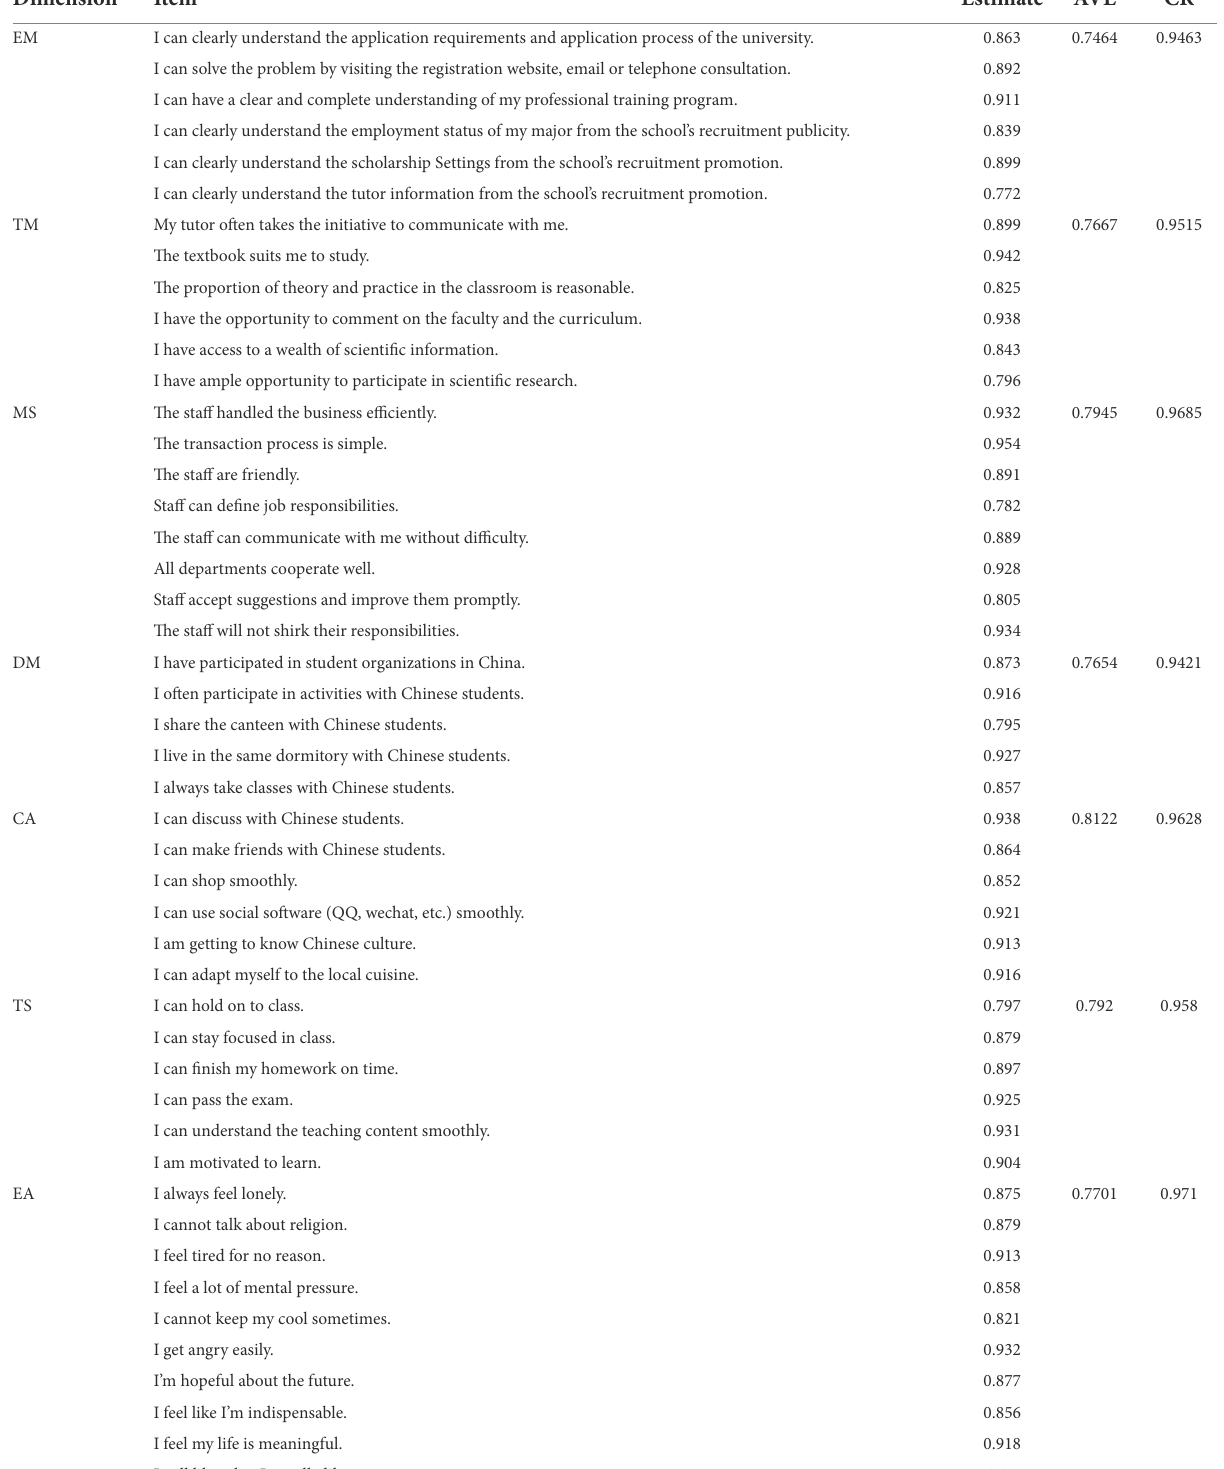
TABLE 1 Average variance extracted, composite reliability ( N = 475). Dimension Item Estimate AVE